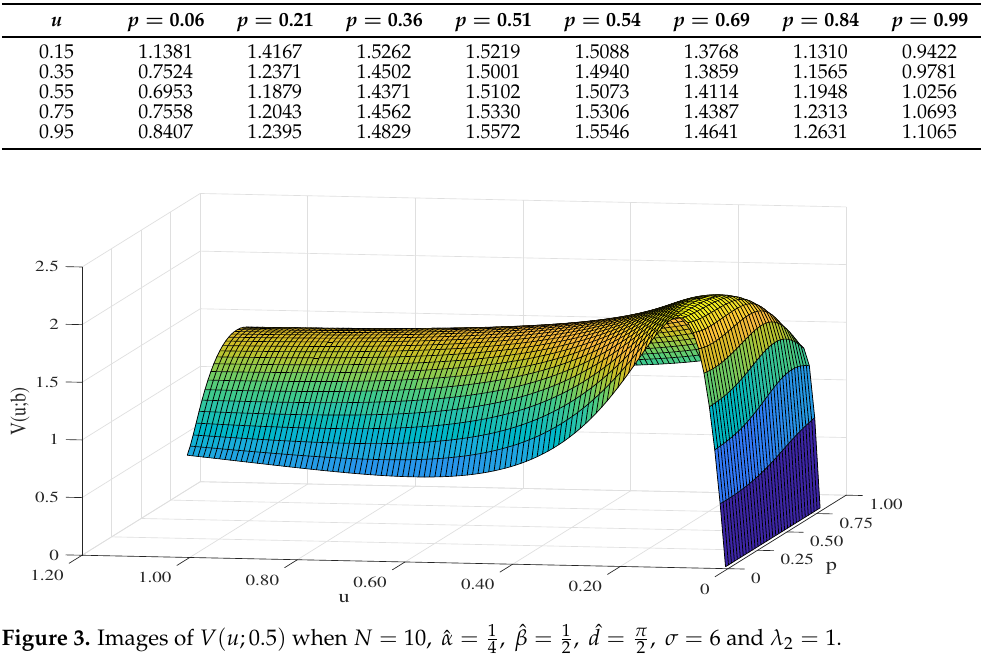
, ˆ β = 1 , ˆ d = π , σ = 6 and λ 2 = 1. 2 2 4